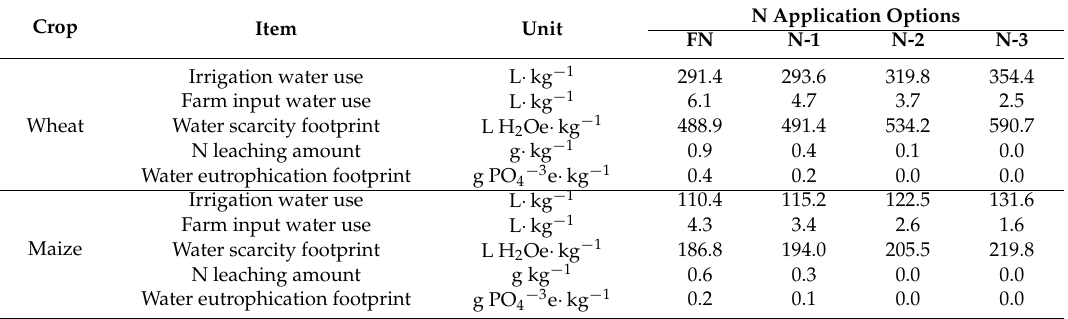
Table 5. Water scarcity footprints and water eutrophication footprints of wheat and maize under different N